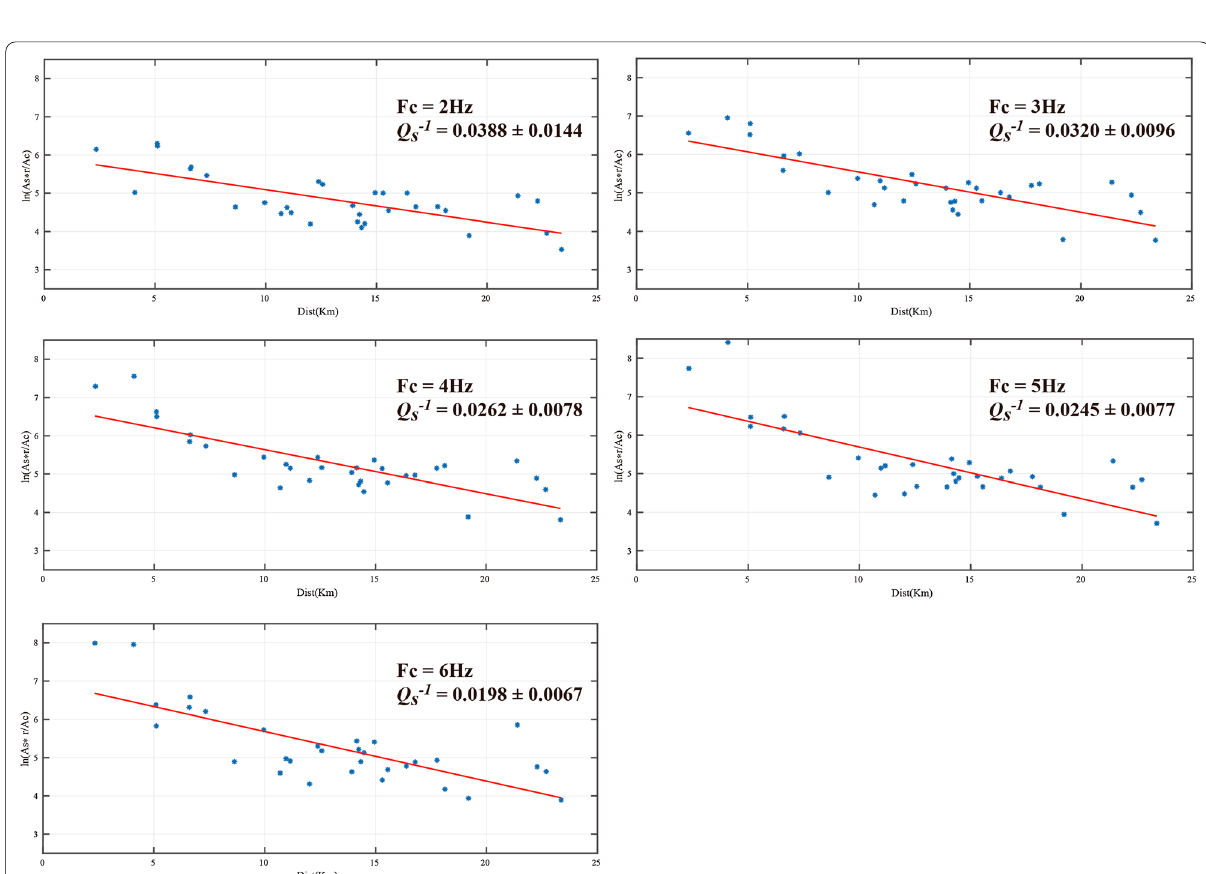
Fig. 12 Coda-normalized RMS amplitude decay of S waves with hypocentral distance after removing anomalous stations. The red solid lines indicate least-squares fits of all stations. The numbers written in each frame are the Q − 1 s